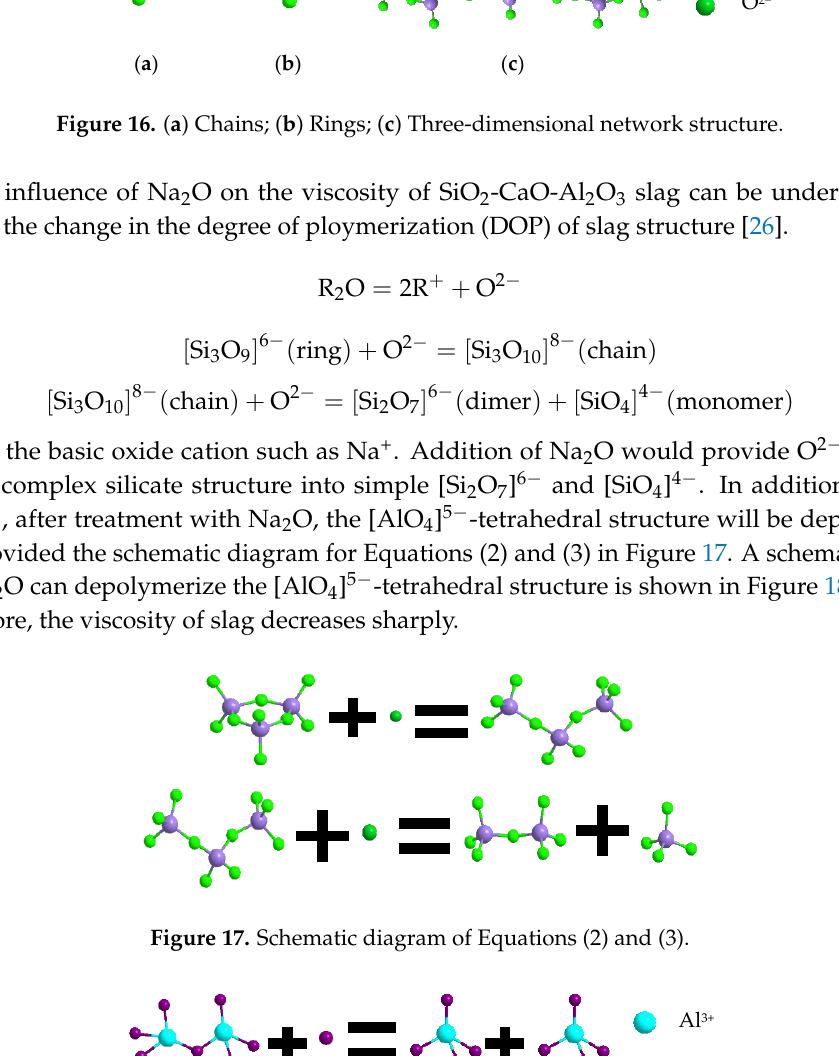
Figure 19. The schematic diagram of Equation (4).